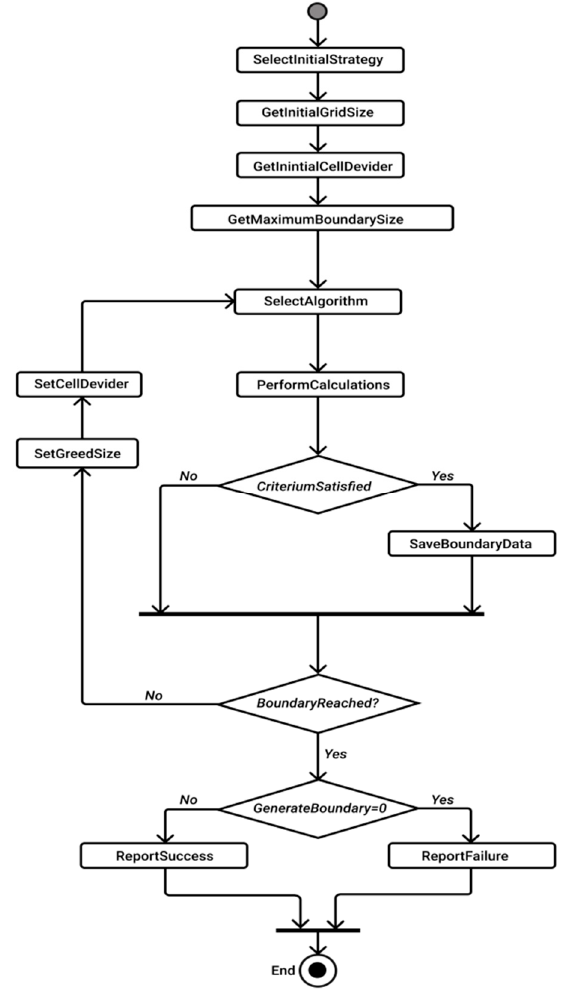
Figure 4. The general algorithm.